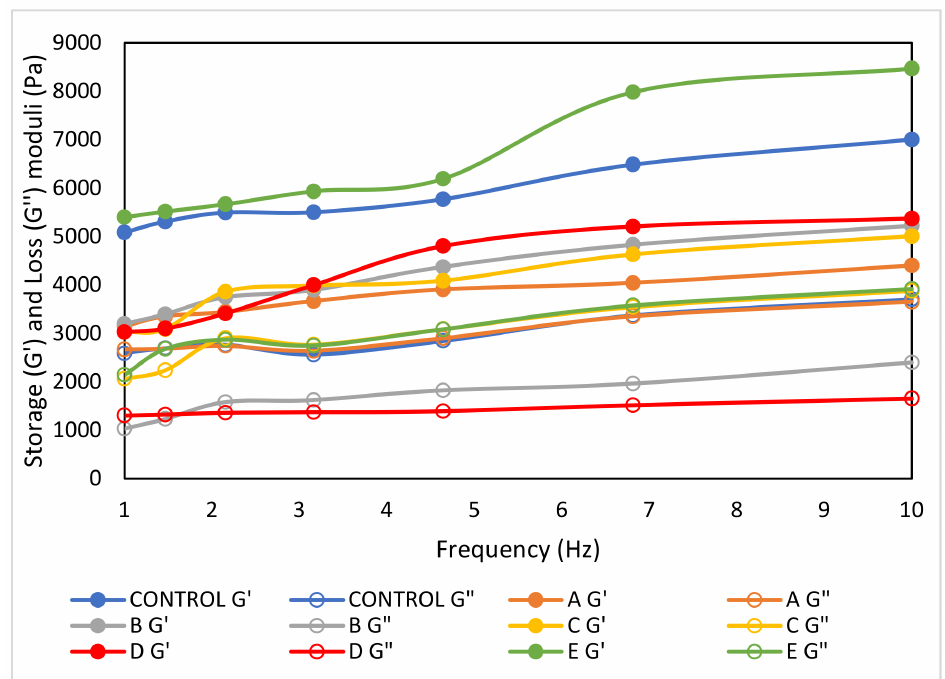
Figure 2. Storage (G (cid:48) ) and loss (G (cid:48)(cid:48) ) moduli of fat-replaced samples with palm shortenings (PS) of various melting ranges (MR) as compared to the control sample with chicken skin. Control (chicken skin), sample A (PS at MR of 33–36 ◦ C), sample B (PS at MR of 38–42 ◦ C), sample C (PS at MR of 44–46 ◦ C), sample D (PS at MR of 45–49 ◦ C), and sample E (PS at MR of 55–60 ◦